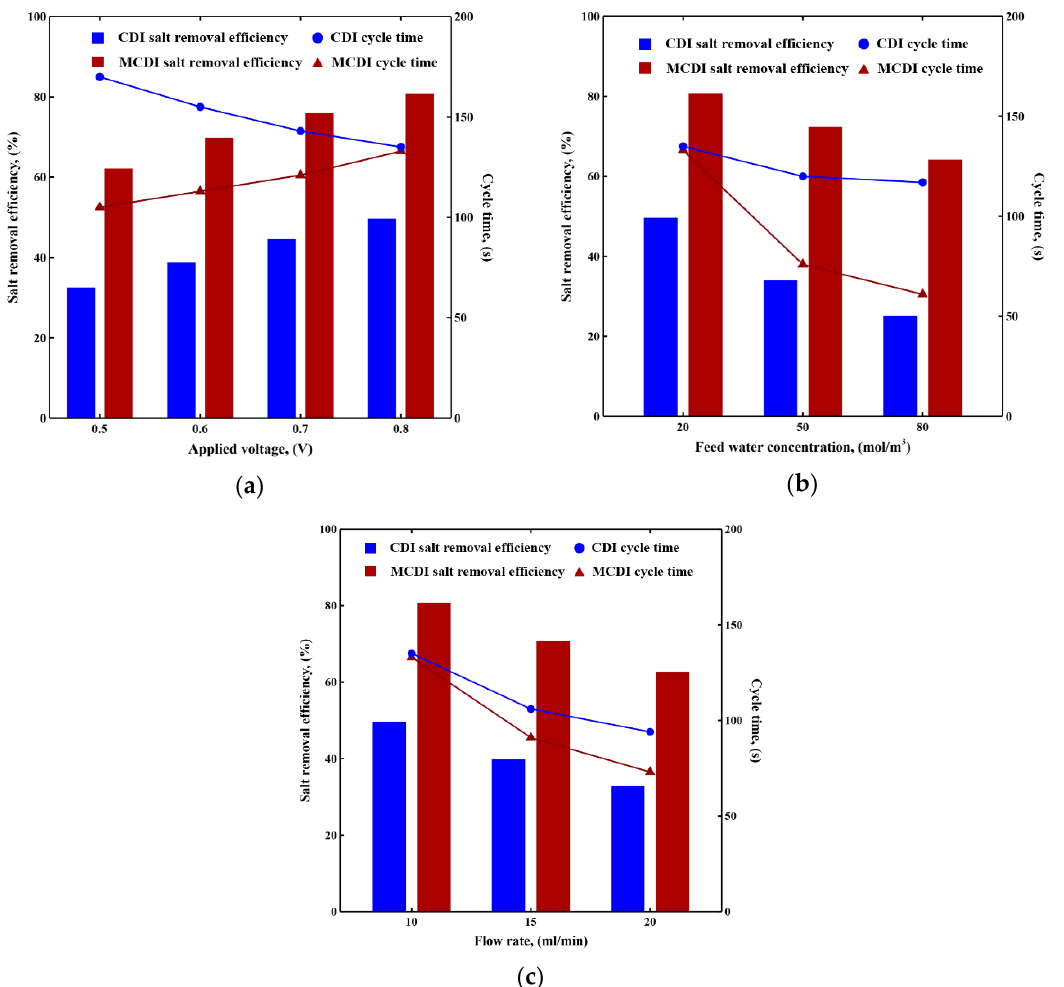
Figure 8. The maximum salt removal efficiency and the corresponding cycle time of CDI and MCDI under ( a ) flow rate of 10 mL/min and feed water concentration of 20 mol/m 3 , ( b ) applied voltage of 0.8 V and flow rate of 10 mL/min, and ( c ) feed water concentration of 20 mol/m 3 and applied voltage of 0.8 V. Lines are used for guiding the eyes.